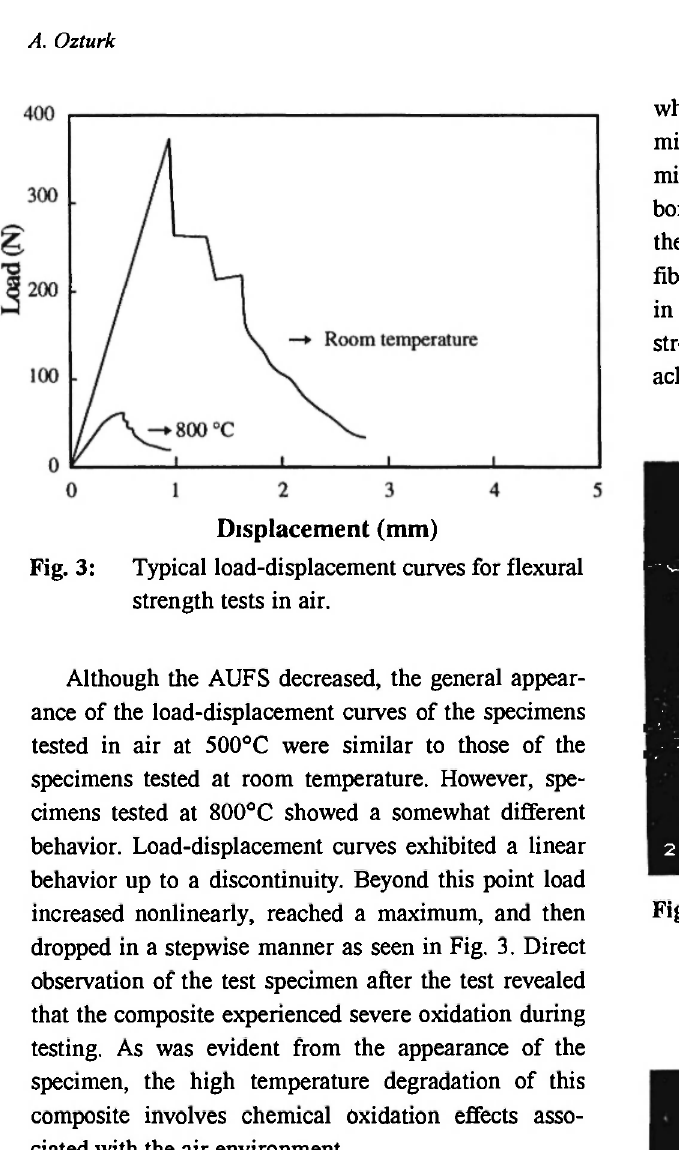
Fig. 4: SEM micrograph of a carbon-carbon composite specimen broken in flexure showing crack branching and delamination.